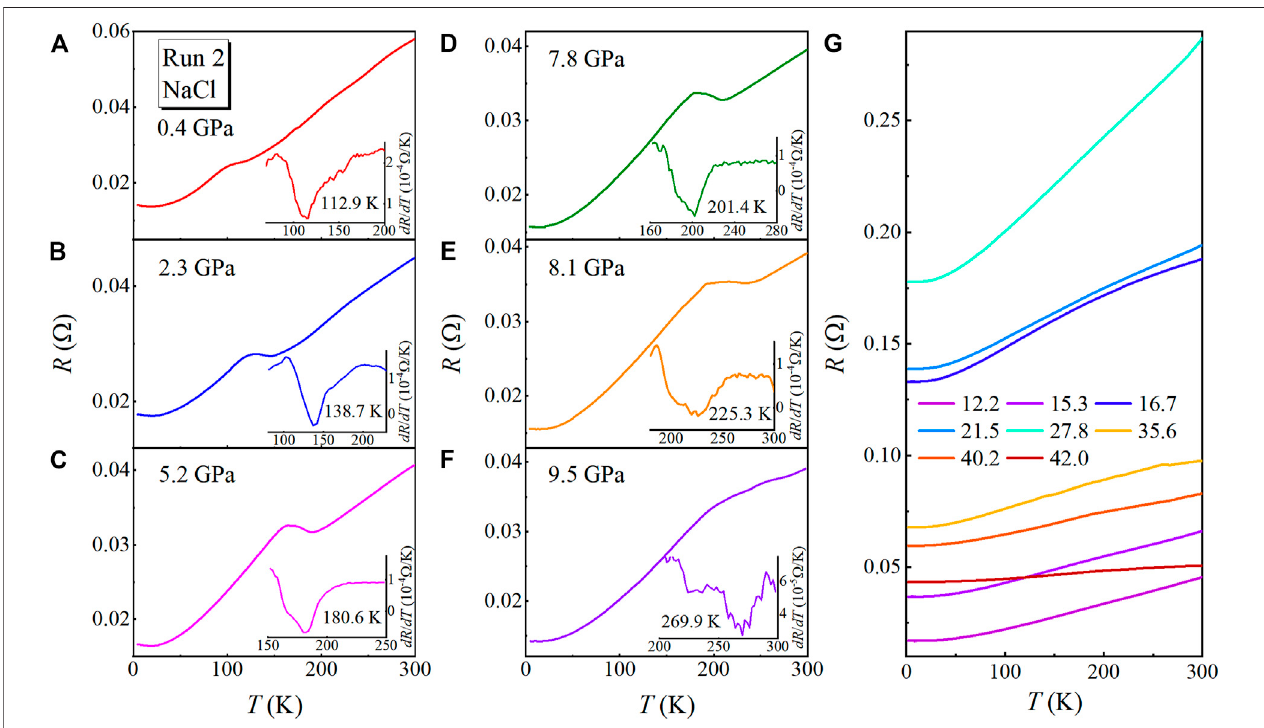
FIGURE3| High-pressureresistancemeasurementswereperformedusingNaClasthepressuremedium(Run2). (A) – (G) Temperaturedependenceofresistance of 1 T -VSe 2 at various pressures. Insets of (A) – (F) : Temperature dependence of d R /d T .